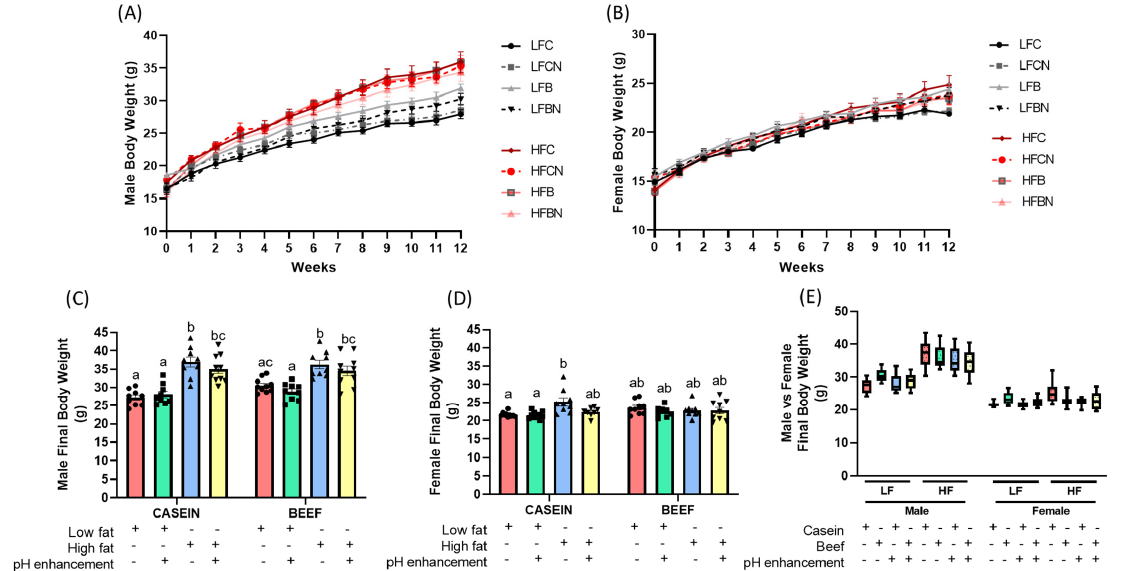
Figure 3. Sex-dependent effects of diet, protein source and pH enhancement on weight gain, and final body weight in diet induced obese male and female mice. Growth curves during the dietary interventions ( A ) male, ( B ) female mice, and the final body weight ( C ) male and ( D ) female mice. ( E ) Final body weight male vs. female mice. Data is presented as mean ± SEM. LFC, low fat casein; LFCN, low fat casein pH enhanced; LFB, low fat beef; LFBN, low fat beef pH enhanced; HFC, high fat casein; HFCN, high fat casein pH enhanced; HFB, high fat beef; HFBN, high fat beef pH enhanced. Common letters on the error bars indicate no significance (e.g., “a” is significantly different from “b” while “ab” indicates no significance compared to “a” and “b”). p < 0.05; n = 8–10.